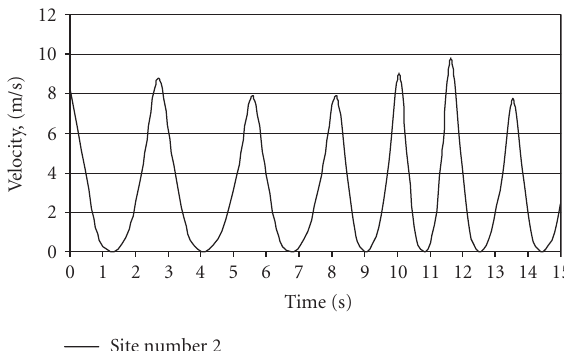
Figure 4: E ff ect of blade profile on mean e ffi ciency under sinusoidal flow conditions: (a) σ = 0.48, (b) σ = 0.64.